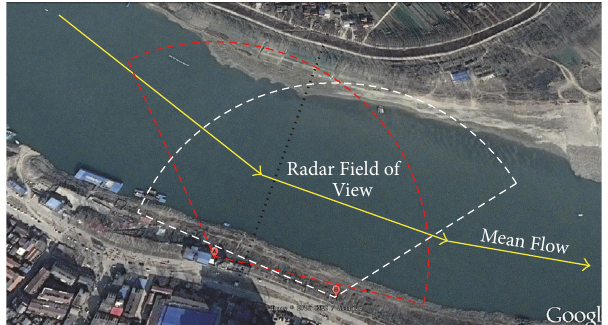
Figure 9: Schematic diagram of dual sites experiment.